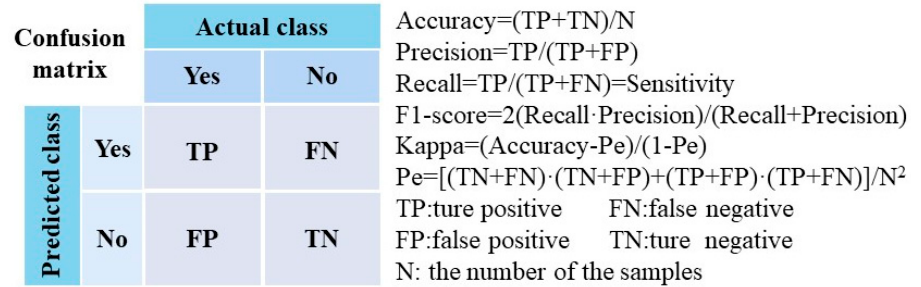
Figure 4. Confusion matrix and performance indexes.